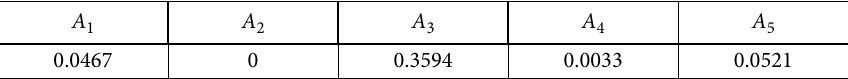
Table 9. The weighted PDA of the enhancement EDAS method based on the PT 1